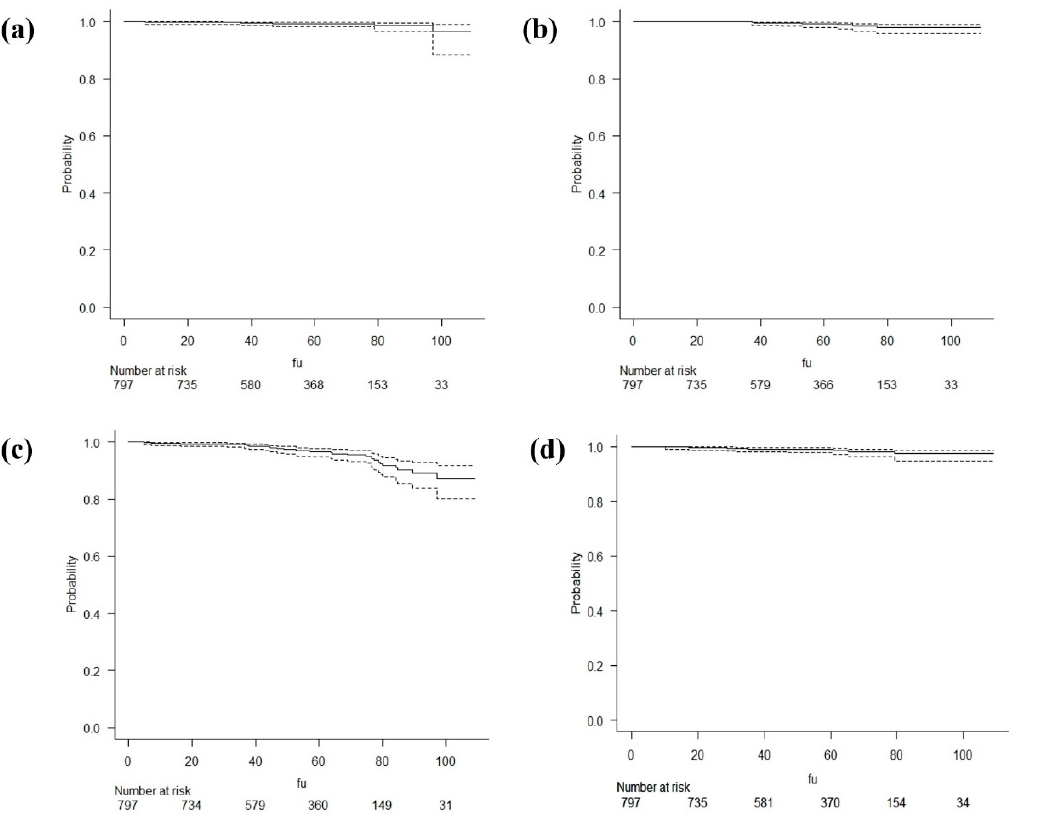
Figure 1. Kaplan-Meier curves for in-field Local Control ( a ), out-field Local Control ( b ), Disease Free Survival ( c ) and Overall Survival ( d ). The dashed lines represent 95% confidence interval in each curve. X axis represents the probability of the event and Y axis the variable time to the event.